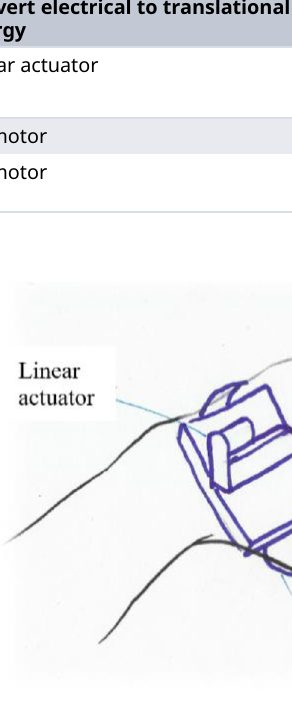
Figure 16. Concept 1 – Linkages to control finger movements.